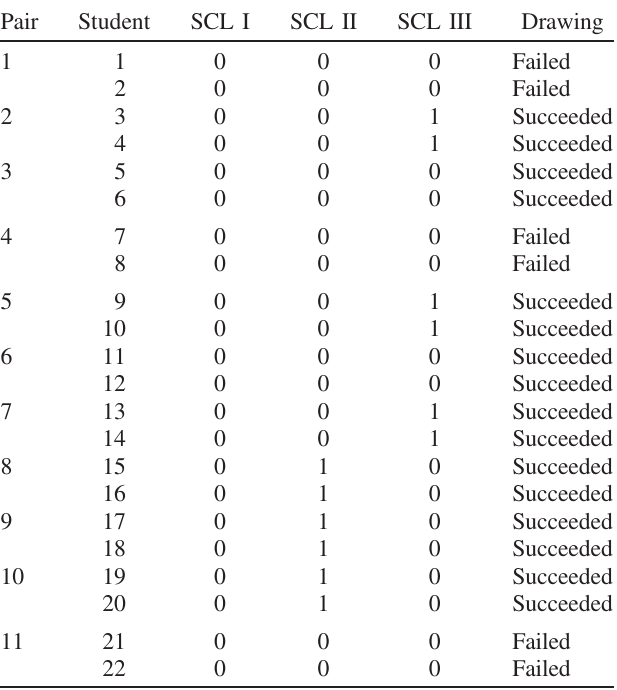
TABLE III. Students ’ results in the scaffolding environment for question (b) (1 indicates that students answer the question correctly, 0 indicates that students answer the question incorrectly).